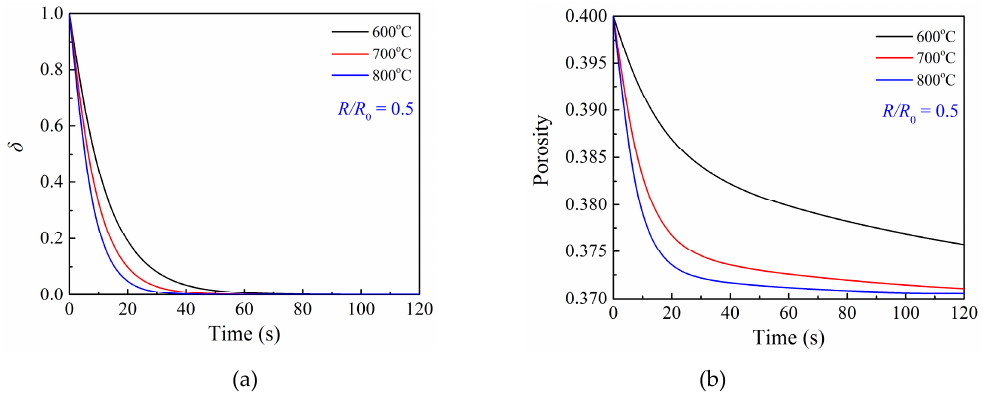
Figure 8. Profiles of ( a ) ratio of unoccupied area on grain surface at R / R 0 = 0.5 and ( b ) local porosity at R / R 0 = 0.5 during the 50_TiO 2 _MM material oxidation reaction in Figure 6( a ).